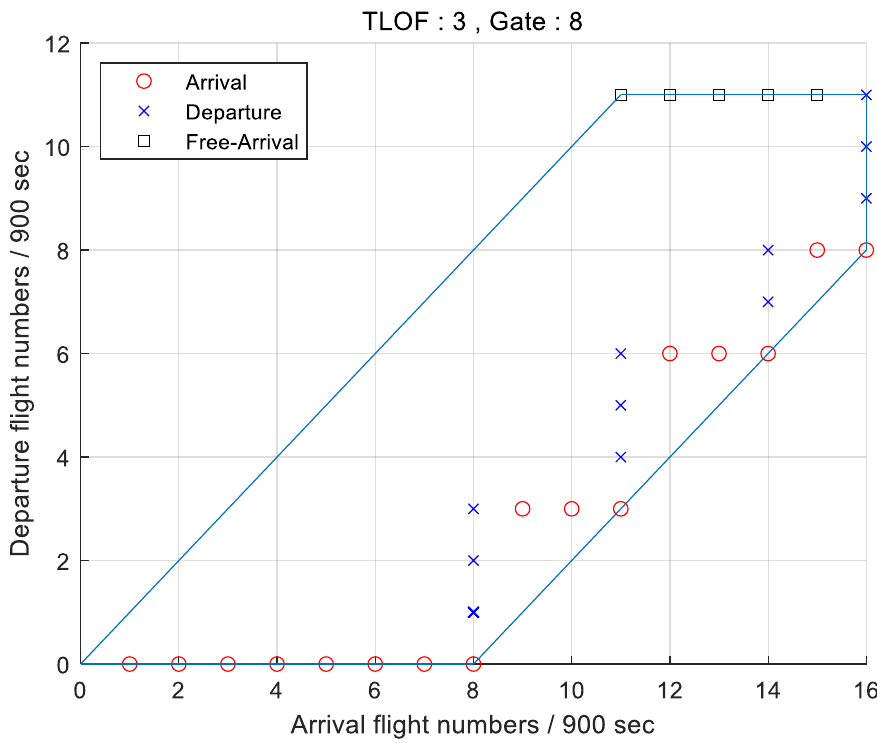
Figure 29. The pier topology capacity of the current Gimpo Airport parking lot that complies with the FAA’s new regulations.